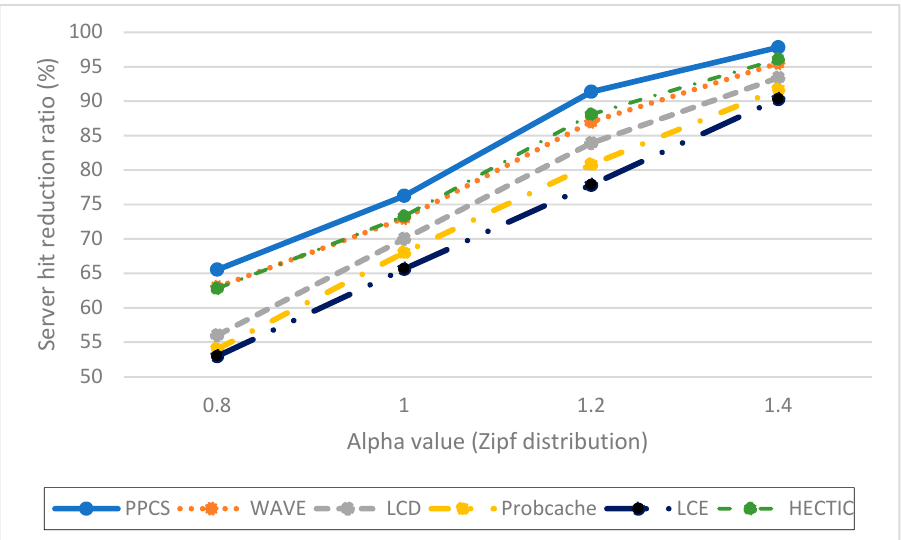
Figure 3. Server hit rate with various Alpha values.